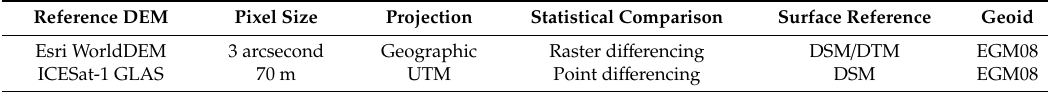
Figure 4. Locations on Earth (in black) where the differences between the EGM96 and EGM08 geoid models differ are between 5 and 11 meters. Table 5. The main features of the reference data.